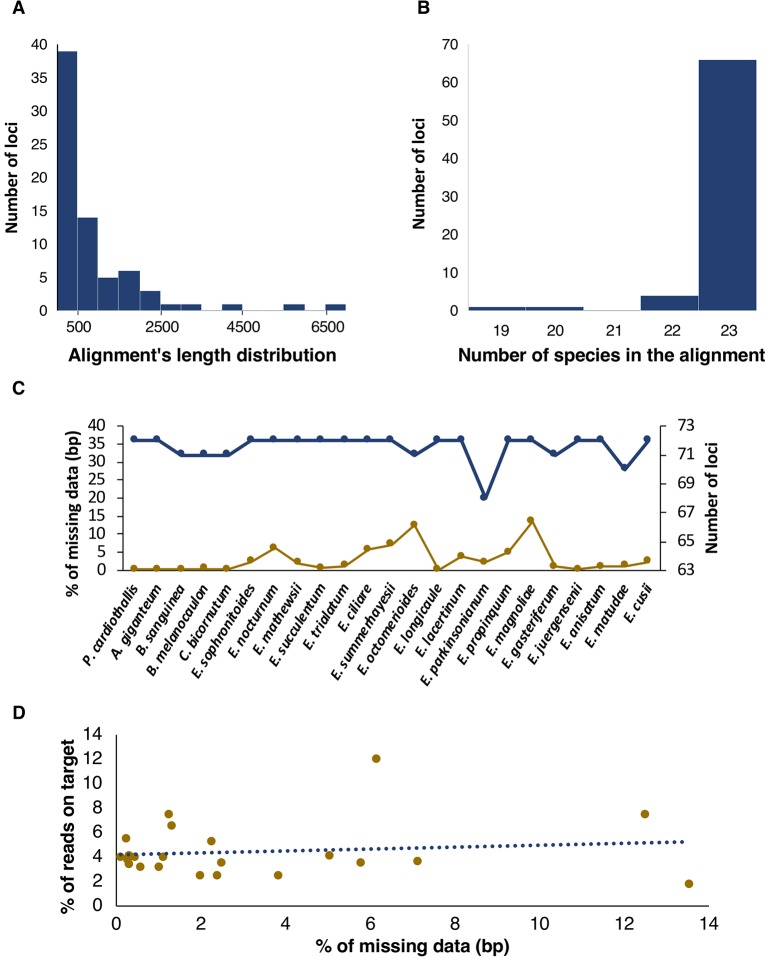
Attributes of retrieved plastid loci. (A, B) Histograms showing length and number of species in the alignments, respectively. (C) Missing data, including bases called as N plus missing flanking regions of loci, in terms of base pairs (bp, yellow points and lines) and number of loci (blue points and lines) per species. (D) % of reads on target as function of % of missing data, in terms of bp.